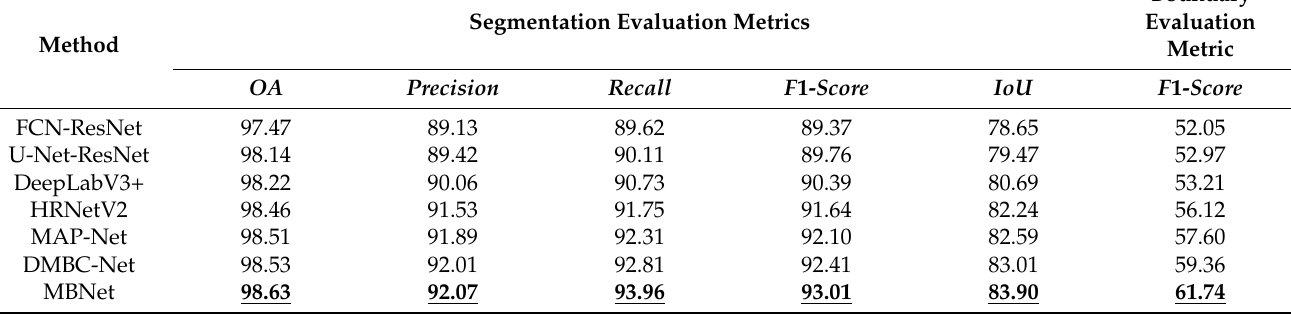
Table 1. Quantitative evaluation (%) of several SOTA algorithms on remote sensing images of mountainous landforms in the test set, where values in bold and underlined are the